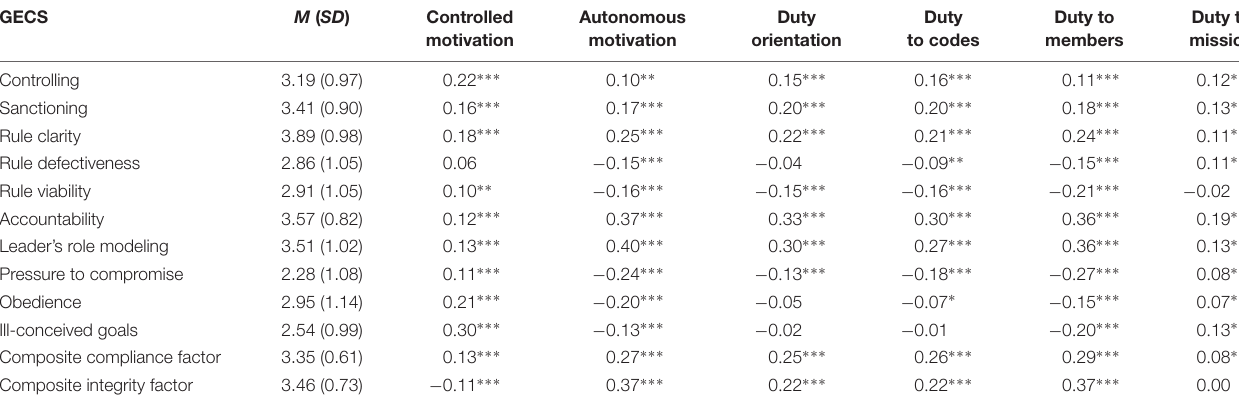
TABLE 7 | Relation between GECS, work motivation and duty orientation (Sample C, Study 3).